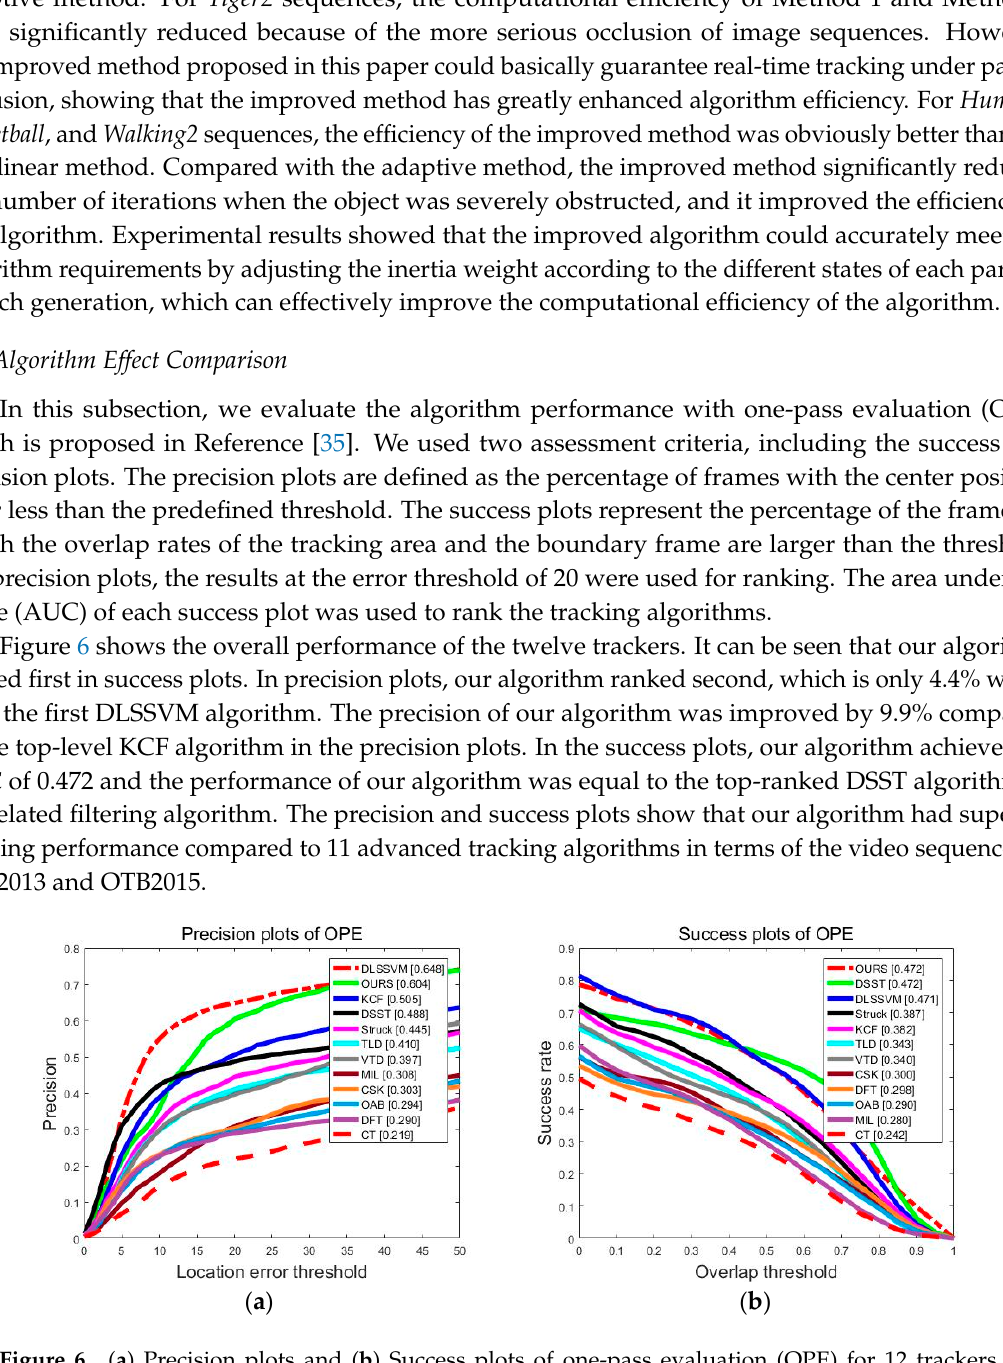
Figure 6. ( a ) Precision plots and ( b ) Success plots of one-pass evaluation (OPE) for 12 trackers. The legend reports the performance score for each